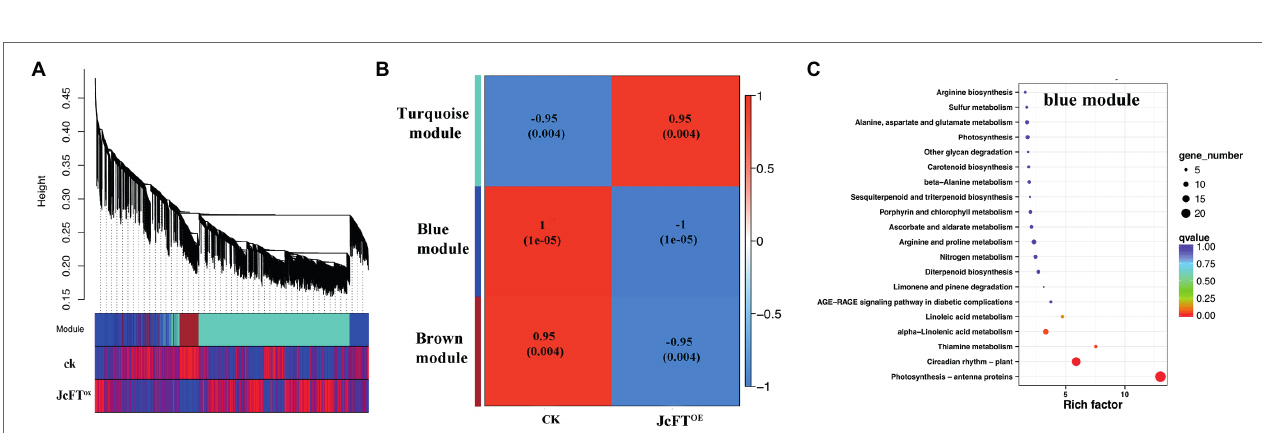
FIGURE 5 | Weighted Gene Co-Expression Network Analysis (WGCNA) of differentially expressed genes (DEGs) and Kyoto Encyclopedia of Genes and Genomes (KEGG) pathway enrichment analysis of the blue module. (A) Dendrogram of DEGs and heat map of trait correlations. The map is divided into three parts: top, dendrogram of DEGs; middle, colors of modules of corresponding DEGs; bottom, correlations between sample DEGs and their modules. An increase in redness indicates a more positive correlation, and an increase in blueness indicates a more negative correlation. (B) Correlation heat map between modules and traits. The closer the correlation is to the absolute value of 1, the more likely the trait is associated with gene function of the module. (C) KEGG pathway enrichment analysis of genes in the blue